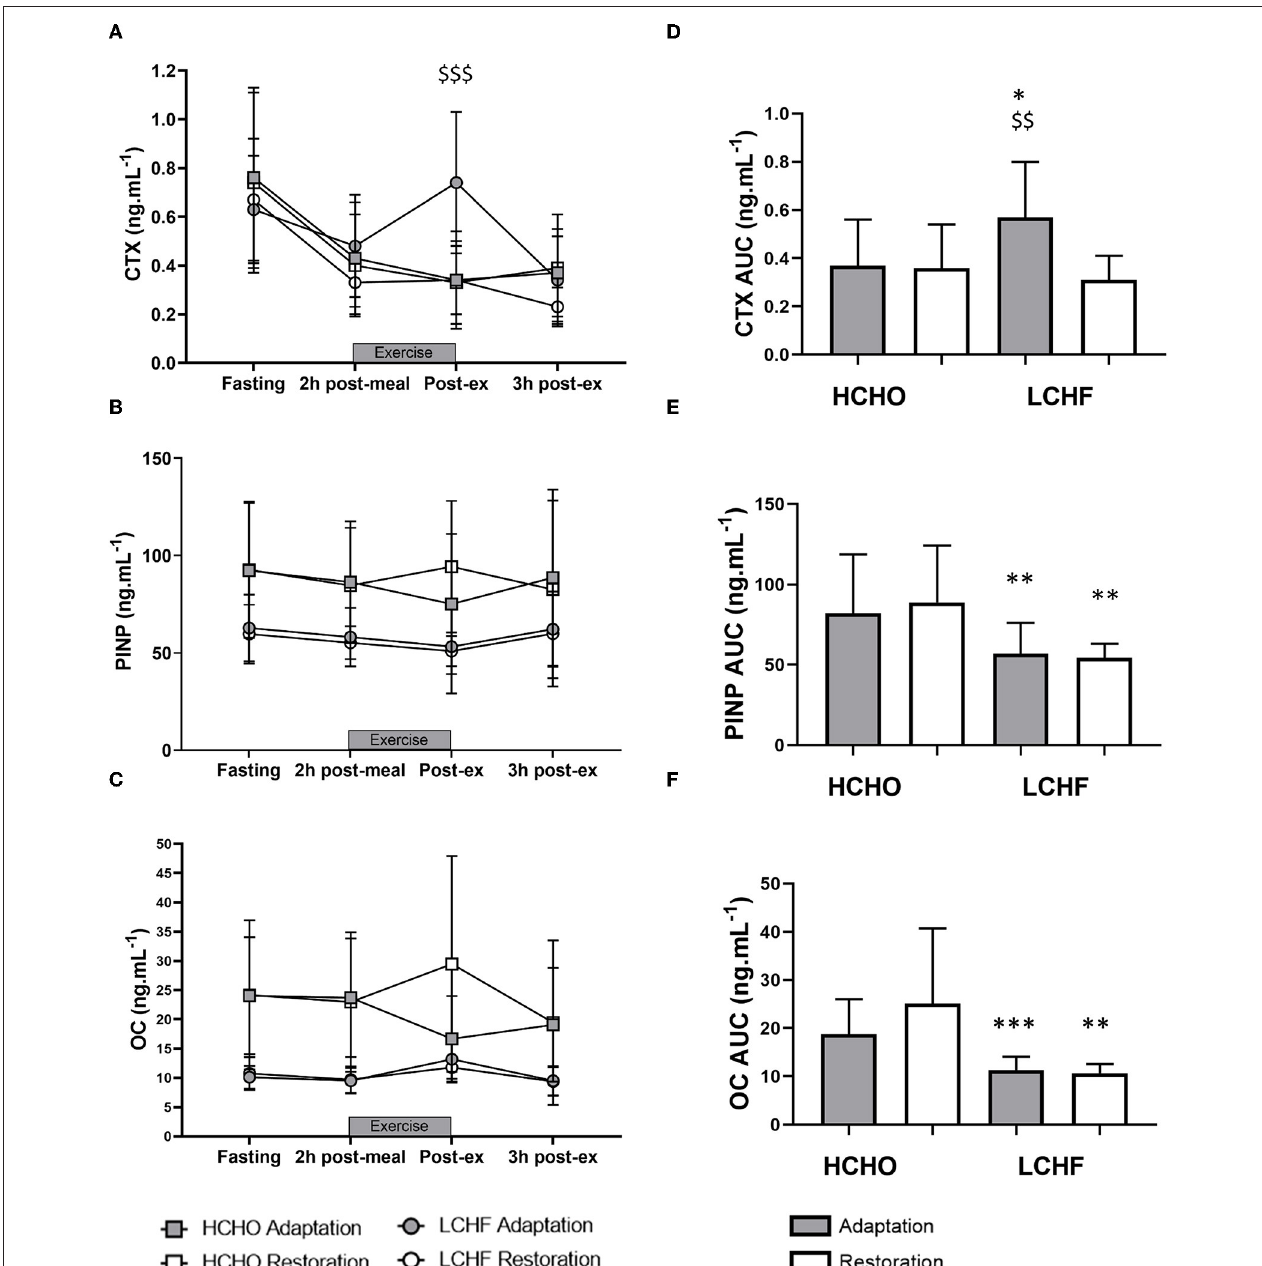
FIGURE 4 | Time course of changes in bone marker concentrations across exercise (left panel) and exercise area under curve (right panel) for serum C-terminal telopeptide of type I collagen (CTX) (A,D) , procollagen 1 N-terminal propeptide (P1NP) (B,E) , and osteocalcin (OC) (C,F) after acute reintroduction of carbohydrate (right panel). Gray bars/symbols represent Adaptation, and white bars/symbols represent Restoration. Squares and circles represent high carbohydrate (HCHO) and low carbohydrate high fat (LCHF), respectively. Gray bars represent a hybrid laboratory/field 19–25km walk test at ∼ 75% VO 2 max. Data are means ± standard deviations. $$ p < 0.01; $$$ p > 0.001 denotes significant within-group difference compared to Restoration. * p < 0.05; ** p < 0.01; *** p < 0.001 denotes significant differences between diet groups at a specific time point.